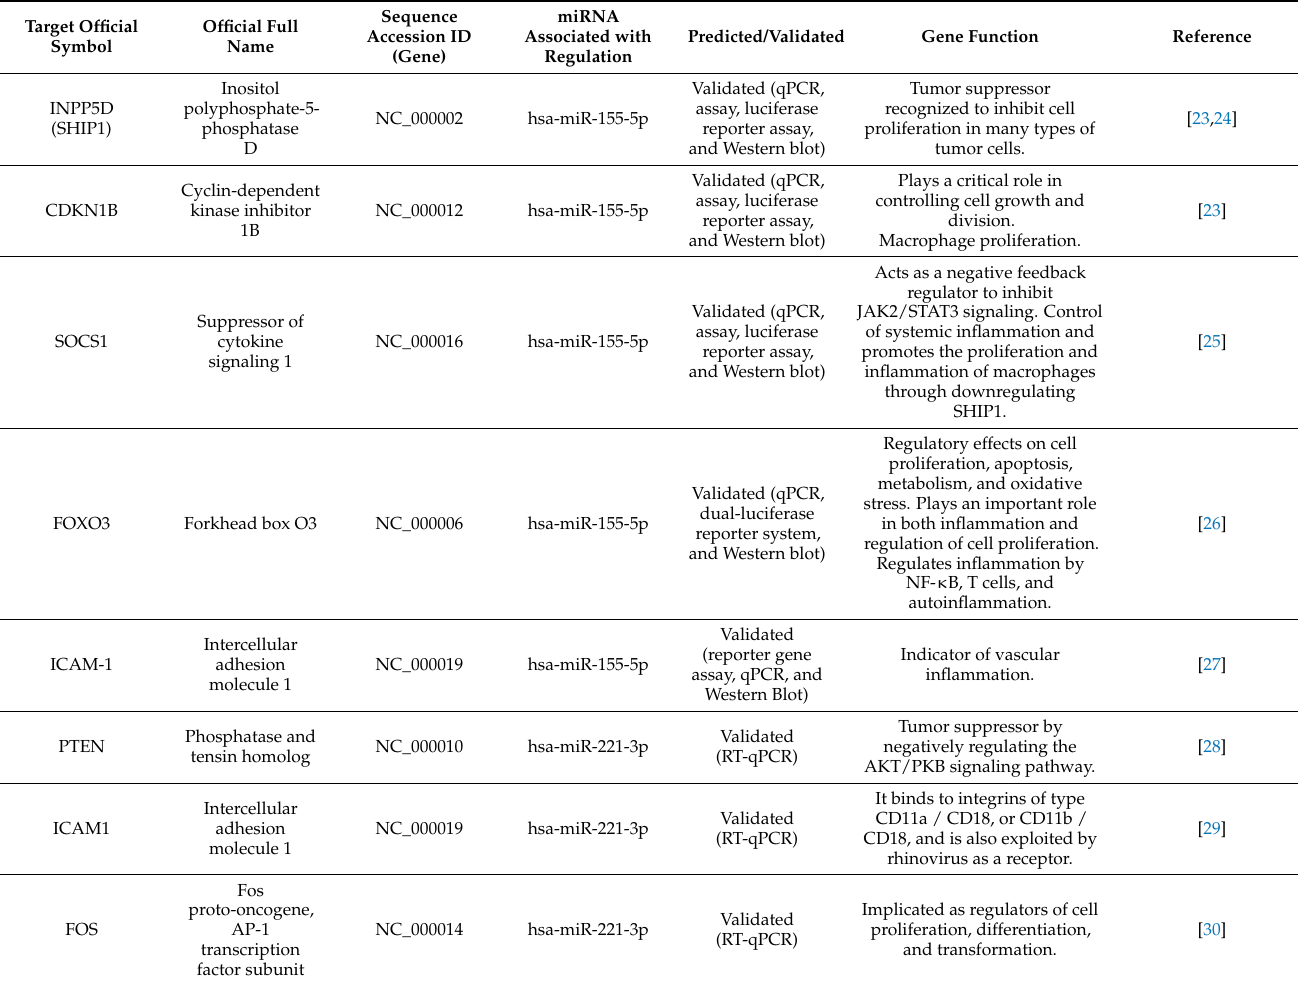
Validated (qPCR, assay, luciferase reporter assay, and Western blot)